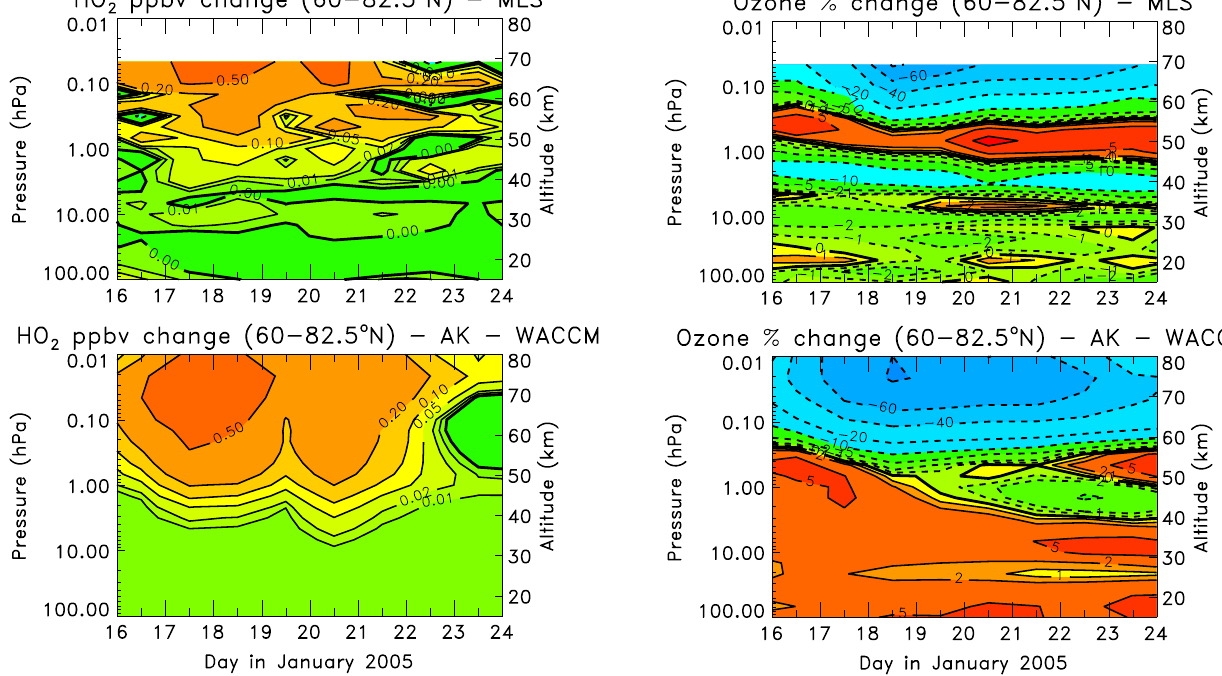
Fig. 6. Daily averaged HO 2 changes from Aura MLS measure- ments (top) and WACCM3 B average predictions (bottom) for the 60–82.5 ◦ N band. An average observed (predicted) HO 2 profile for the period 1–14 January 2005 was subtracted from the observed (predicted) HO 2 values for the plotted days (16–23 January 2005). The contour intervals for the HO 2 differences are − 0 . 1, 0.0, 0.01, 0.02, 0.05, 0.1, 0.2, and 0.5ppbv. The MLS averaging kernel (AK) was used to sample the WACCM3 results.